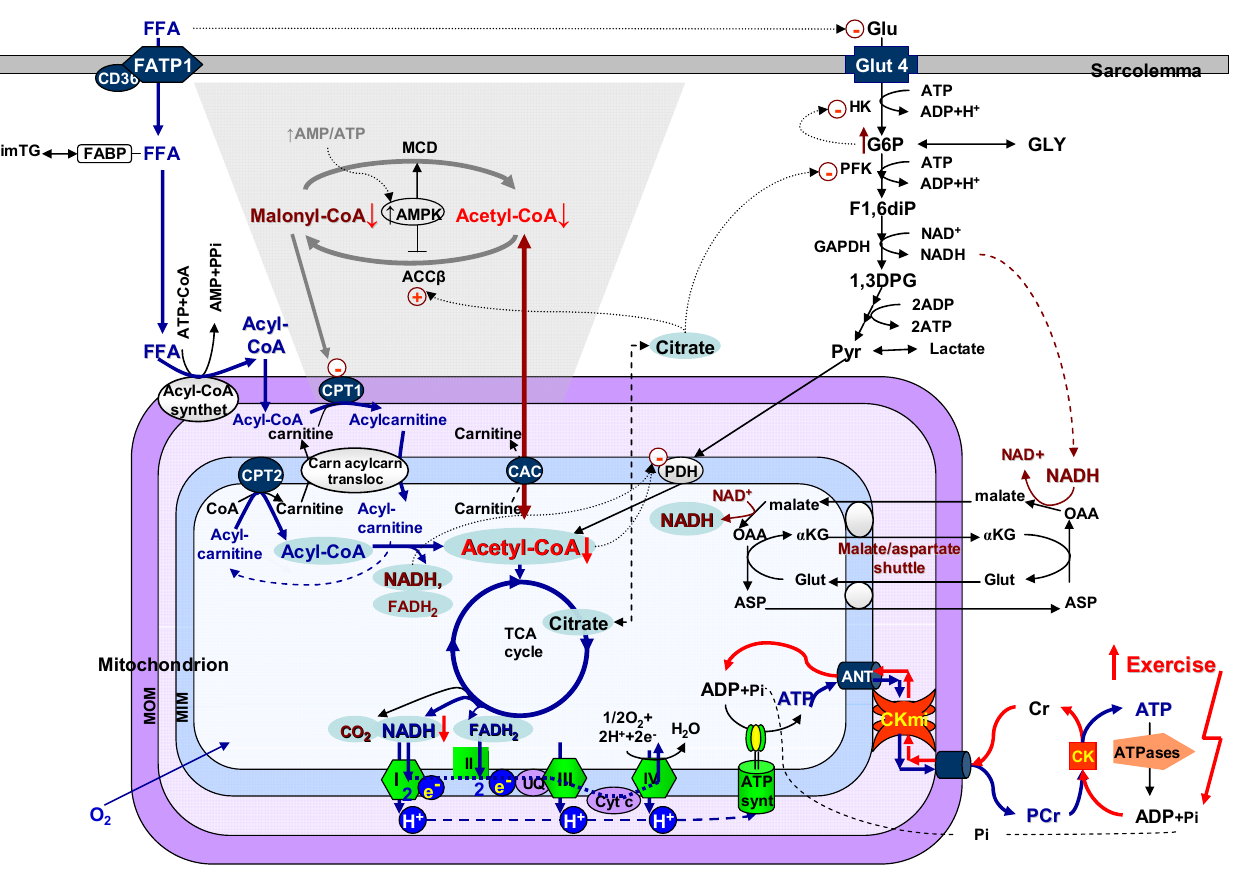
Figure 7. The scheme of substrate supply for mitochondrial respiration and the mechanisms of feedback regulation of the fatty acid and glucose oxidation during workload elevation in oxidative muscle cells: central role of TCA cycle intermediates. Reproduced from reference [132] with